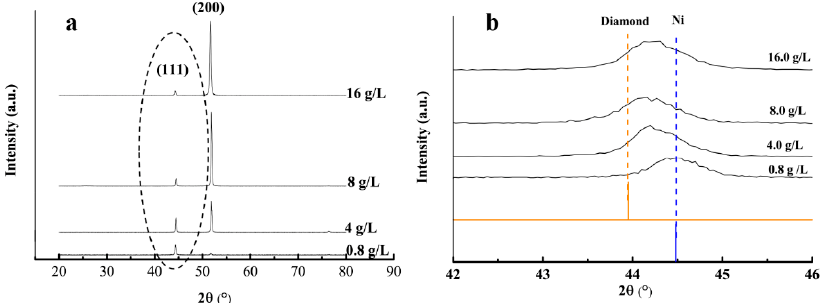
Figure 6. ( a ) Full X-ray diffraction (XRD) spectrum of the composite coating prepared with various nanodiamond concentrations in the plating solution and ( b ) the partial magnification of the XRD spectra marked within a dashed ellipse in ( a ).